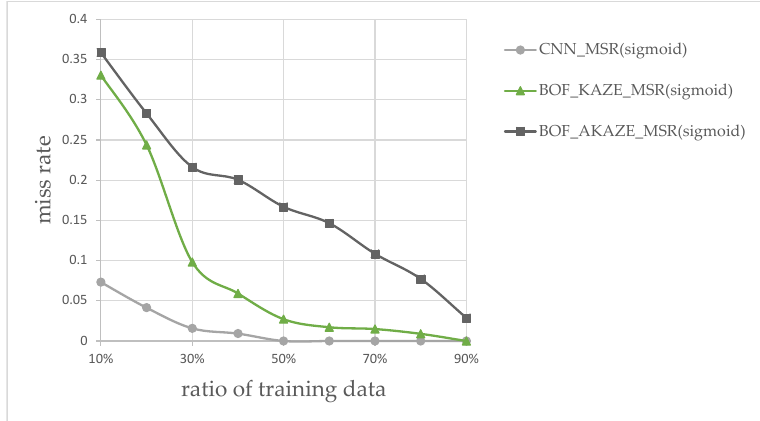
Figure 16. Miss rates vs. training data ratio for classifiers.